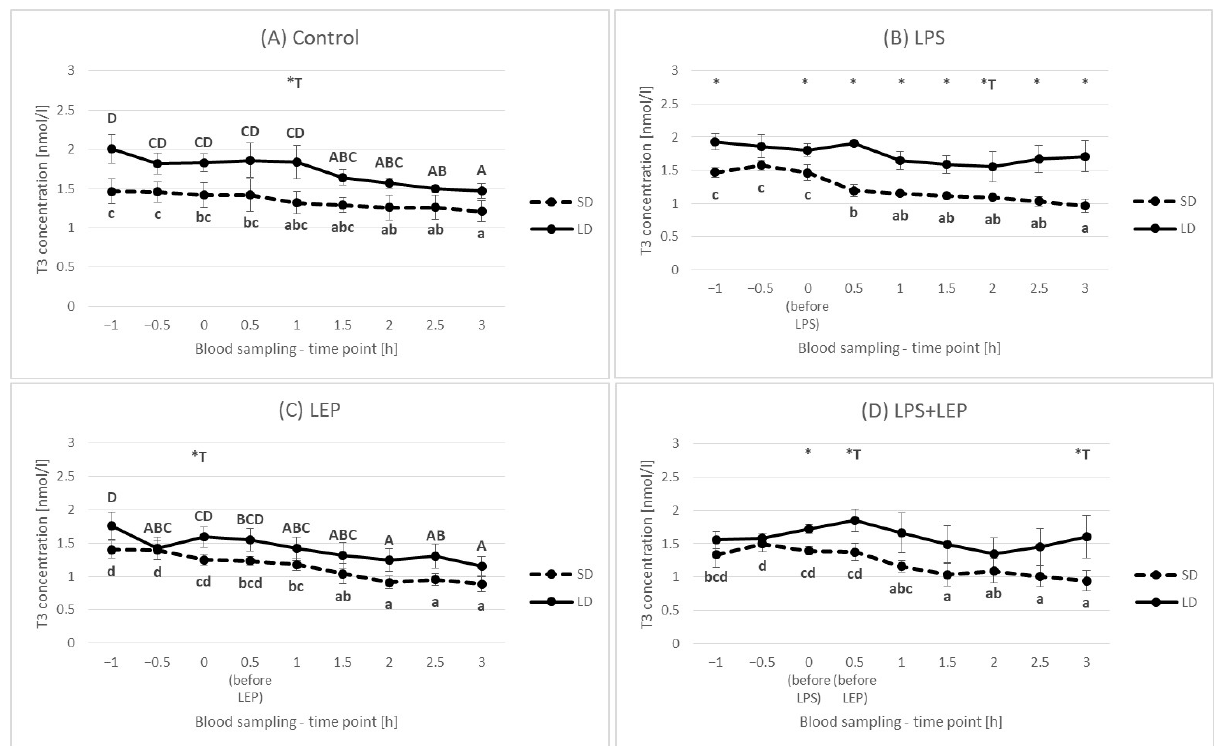
Figure 14. Plasma triiodothyronine (T3) concentration for each experimental group separately (control ( A ), LPS ( B ), LEP ( C ) and LPS + LEP ( D )) at each examined time point and season; *—indicates